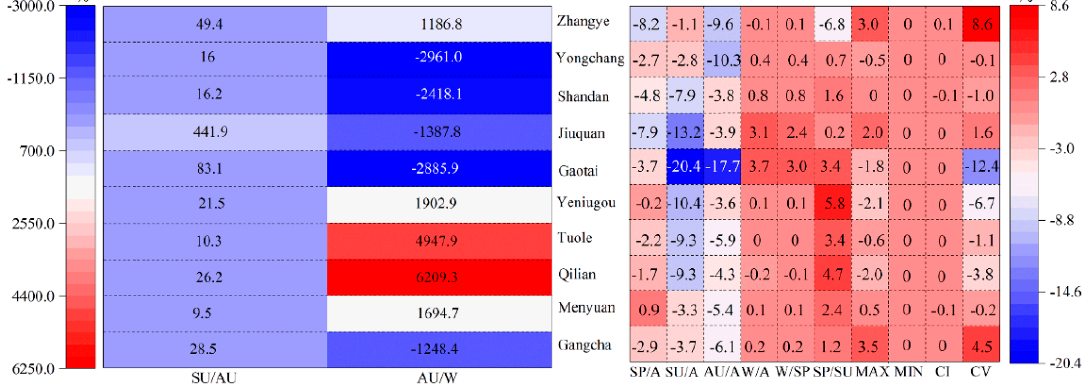
Figure 7. Temporal changes of 12 precipitation variable metrics after abrupt shifts.